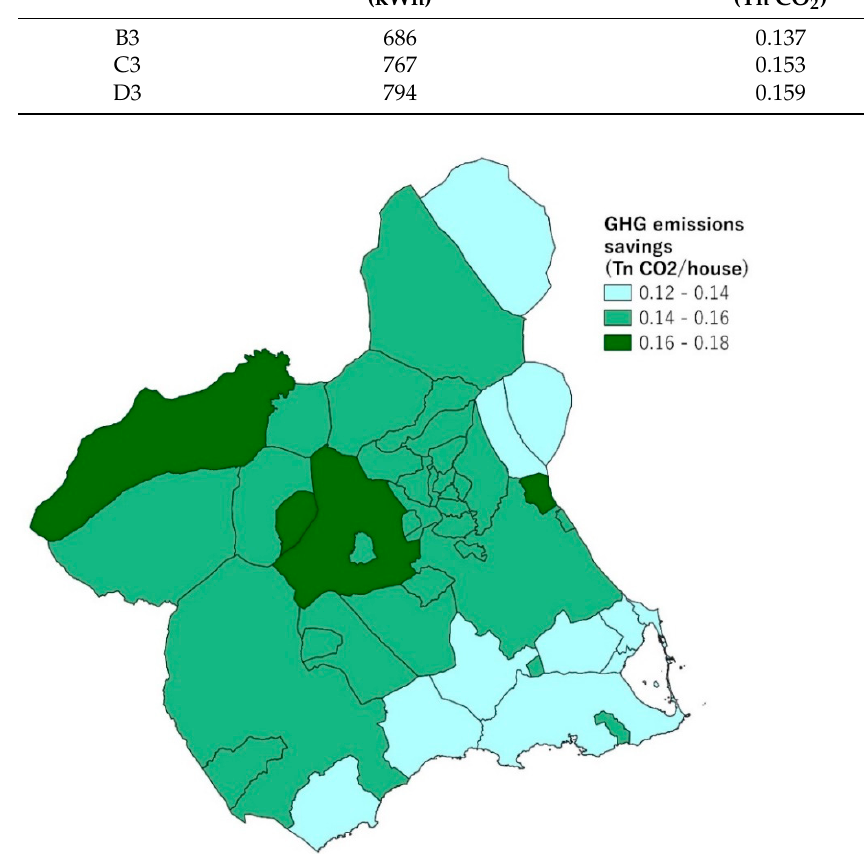
Figure 13. Map of GHG emissions savings per house (Tn/y) considering a complete migration of the energy residential sector to shallow geothermal.